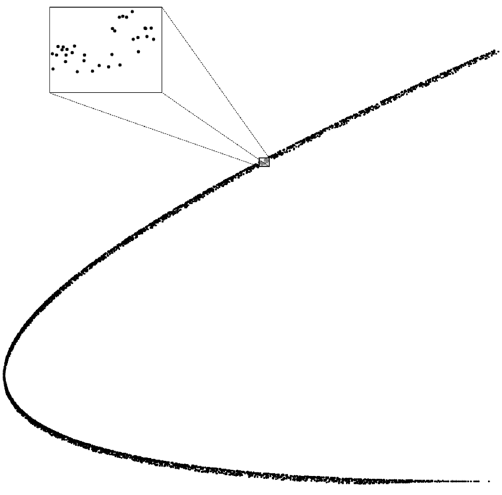
1 or I 2 depending on the scale that is considered. d ¼ d ¼